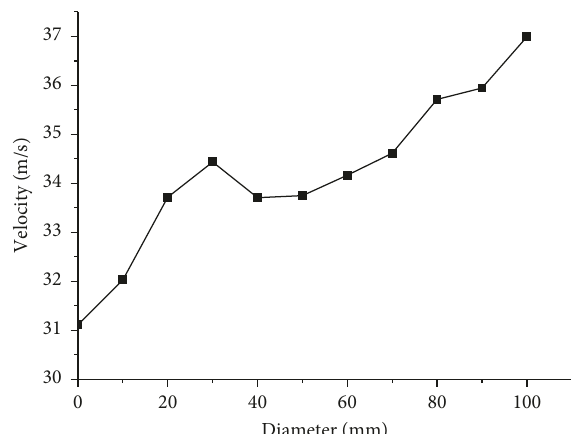
Figure 15: Changing curve of the maximum speed of sacked gangue with different vent